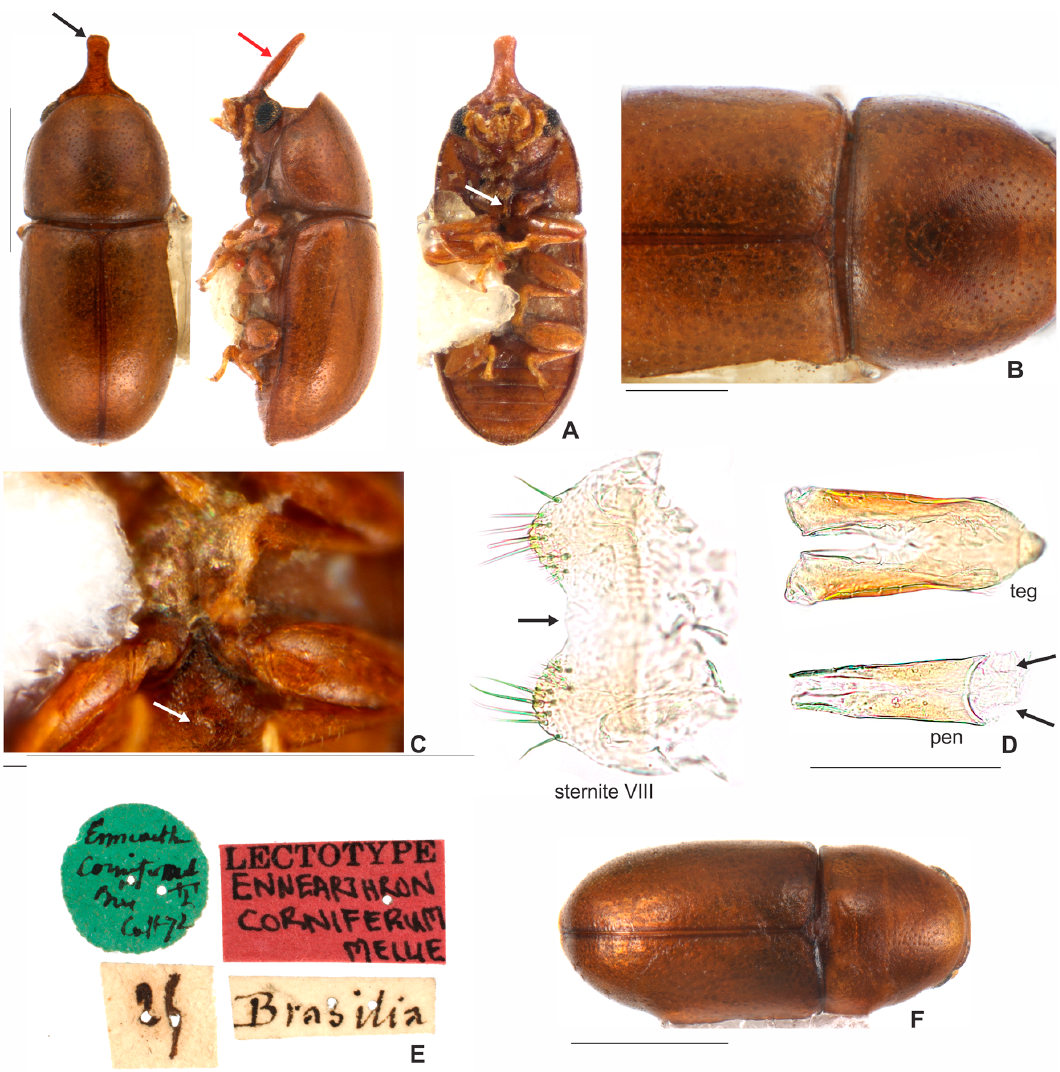
Figure 3. Ceracis cornifer (Melli é ). A–E Male lectotype, ( A ) dorsal, lateral and ventral views, respectively. Frontoclypeal horn subtruncate at apex (black arrow) and laminate in lateral view (red arrow); prosternal process thin but not laminate (white arrow), ( B ) pronotal punctation, ( C ) first abdominal ventrite with a sex patch at the centre (white arrow), ( D ) male terminalia, showing sternite VIII (with a deep concave emargination at middle, black arrow), tegmen (teg), penis (pen, basal edge blunts; black arrows), ( E ) labels of the lectotype deposited in the Mus é um National d’Histoire Naturelle, MNHN (Paris, France), ( F ) female plesiotype from Viçosa (MG, Brazil). Scale bars: A = 0.5 mm, B = 0.2 mm, C,D = 0.1 mm, F = 0.5